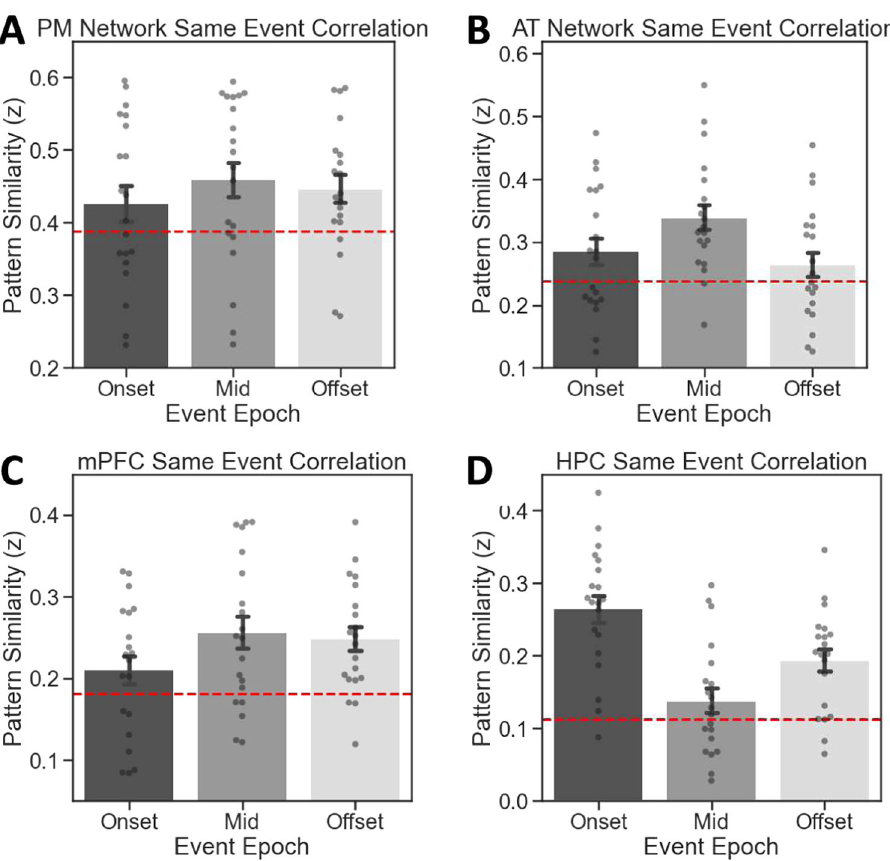
Fig. 8 | Pattern similarity for same-event comparisons by event epoch. A PM Network, B AT Network, C mPFC, D HPC. Red lines indicate the mean pattern